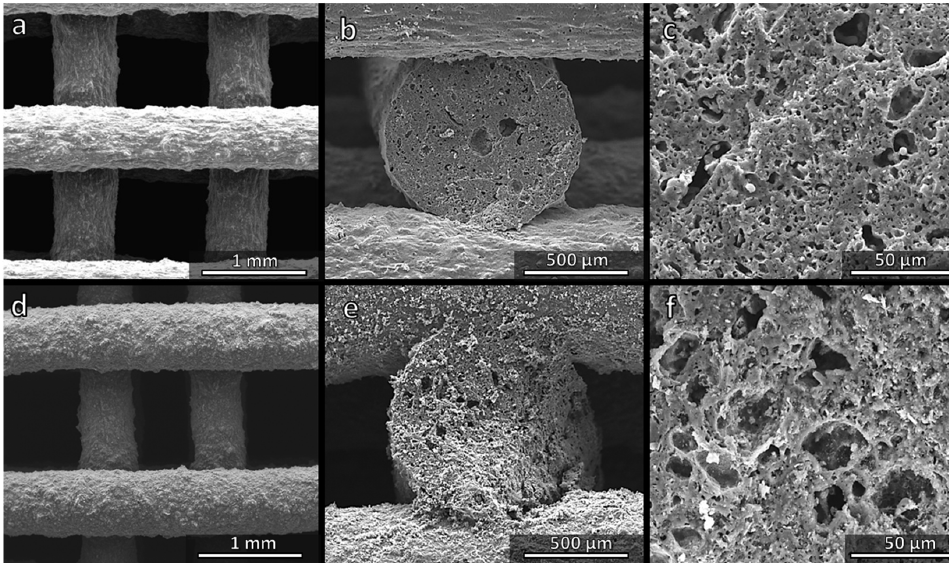
Figure 6. Comparison of the microstructure of Biosilicate ® -like/C composite scaffolds fired in N 2 , from MK ( a – c ) and H44 ( d – f ) silicone polymers.